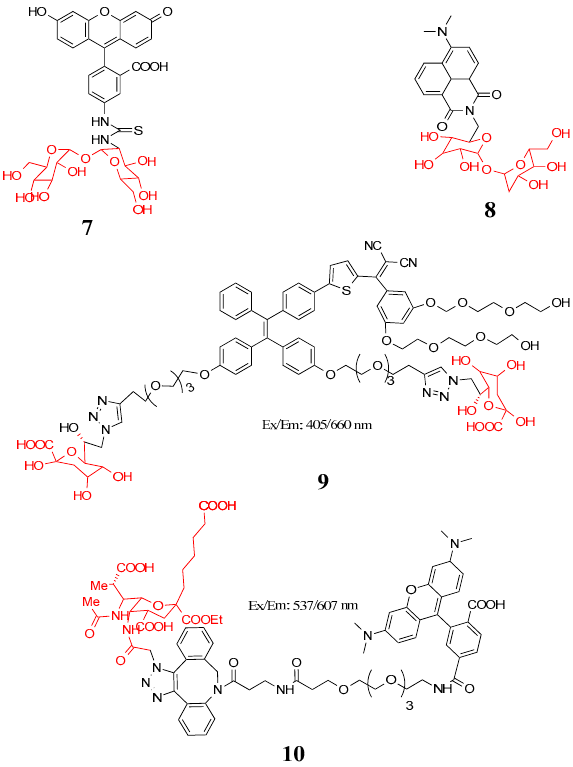
Figure 4. Structure of probes 7 – 10